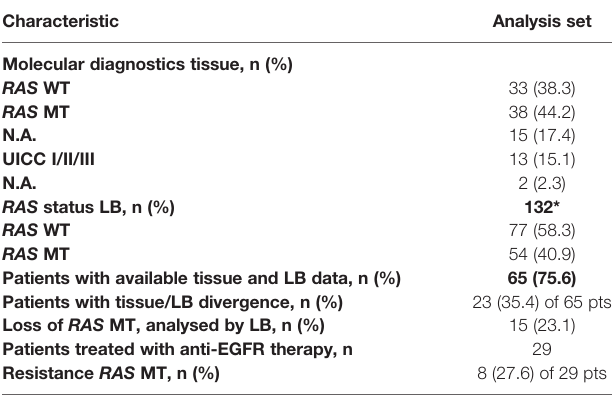
n,number;RAS, ratsarcoma;WT,wild-type; MT,mutant; N.A., not assessable;LB, liquid biopsy; pts, patients. *One patient was ctDNA negative and had no evidence of disease. meaning of bold, most important numbers, patient number and LB